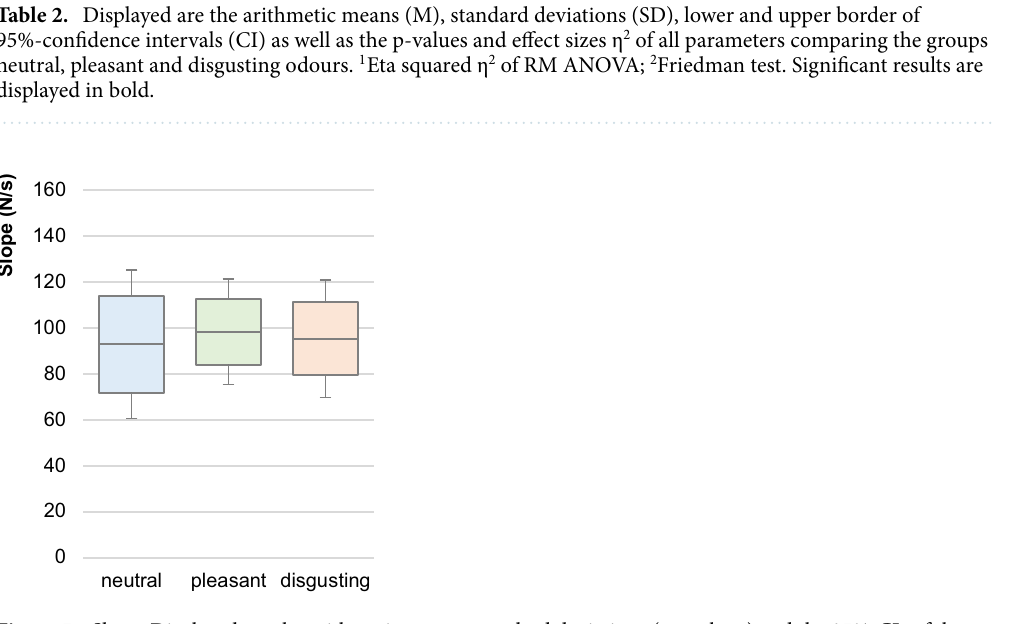
Figure 5. Slope. Displayed are the arithmetic means, standard deviations (error bars) and the 95%-CIs of the decadic logarithmus of slope from 60 to 100% of AFiso unst lg(N/s) comparing the different odours neutral (blue), pleasant (green) and disgusting (orange). The statistical comparisons turned out to be non-significant (p >